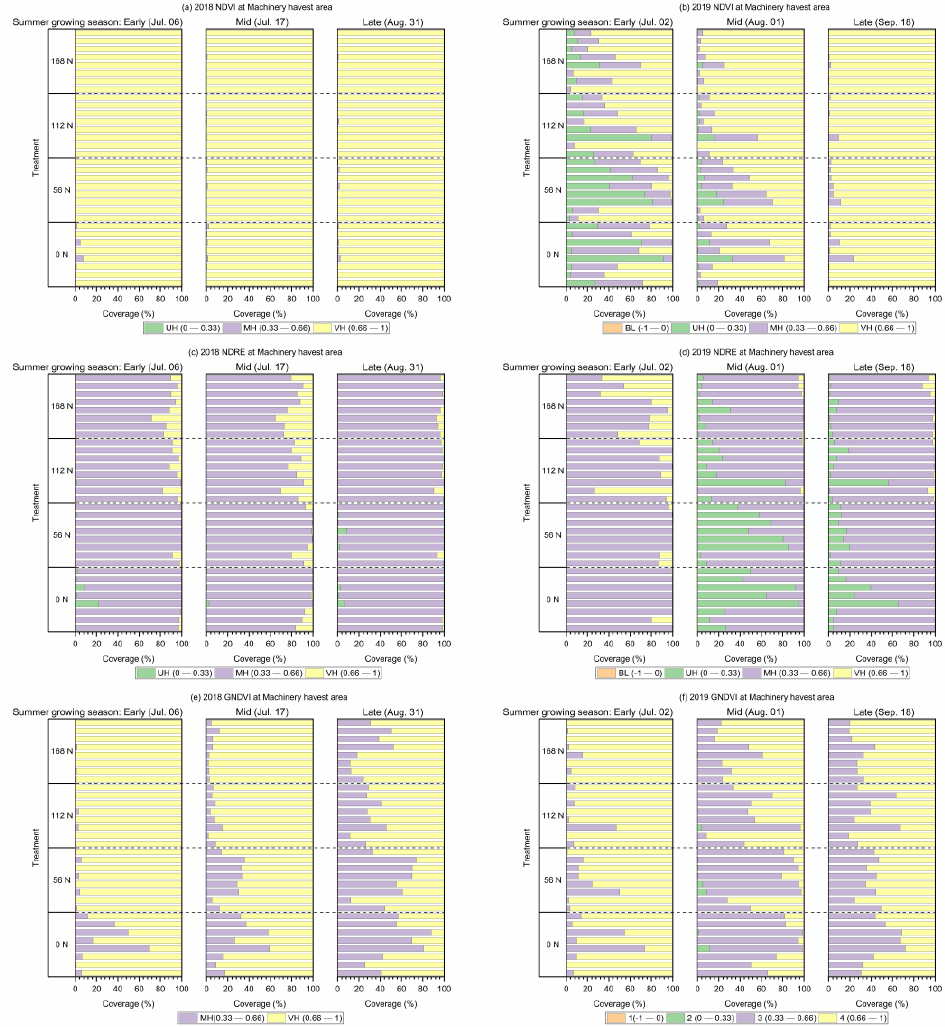
Figure 5. Plant stand health condition coverage corresponding to the reclassified vegetation indices in machine-harvested areas in 2018 and 2019.